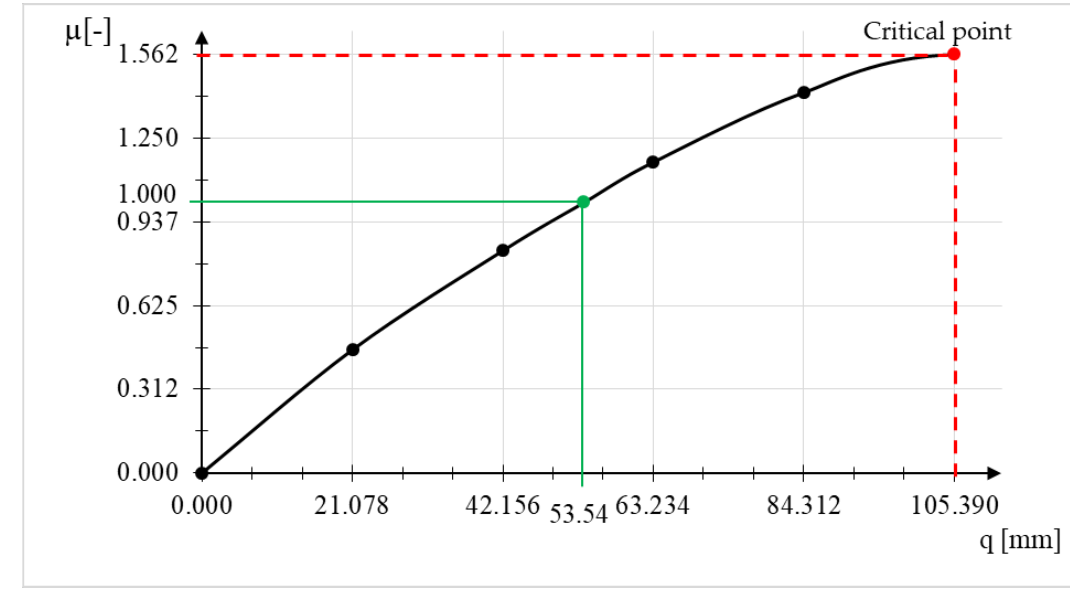
Figure 18. Equilibrium path of the considered bar dome for case 1.